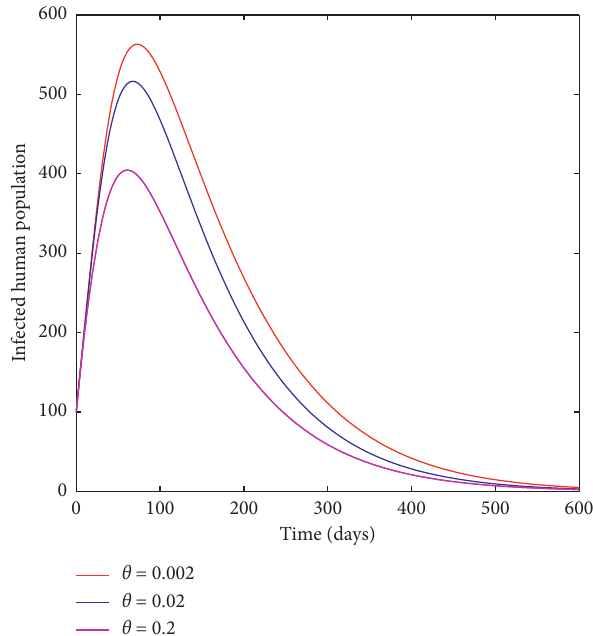
Figure 7: Variation in public health education on infected human population.